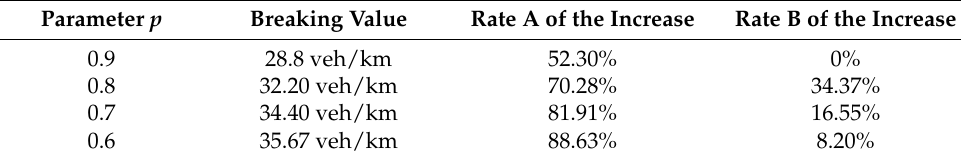
Figure 8. The velocity–density curves. Table 4. Breaking values of density affected by the GPV